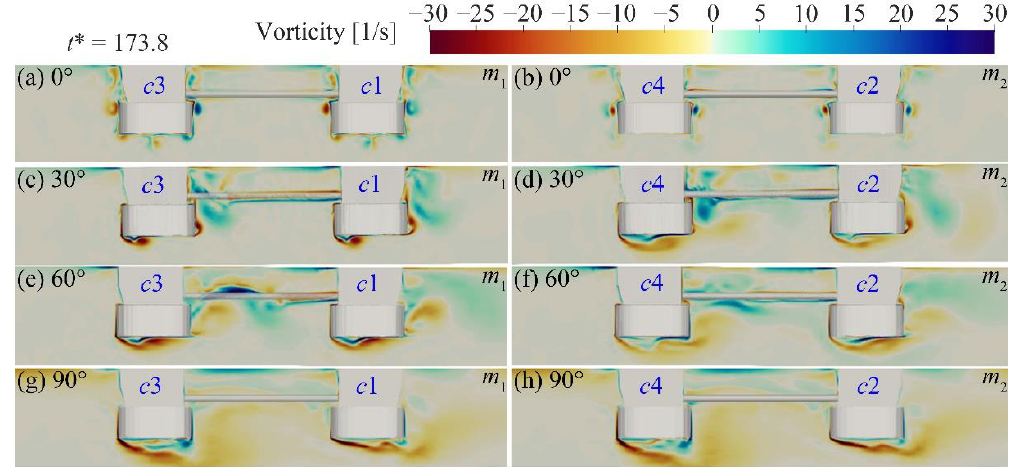
Figure 15. Comparison of the vorticity field around the semi-submersible platform at different directions at profile m 1 and m 2 .